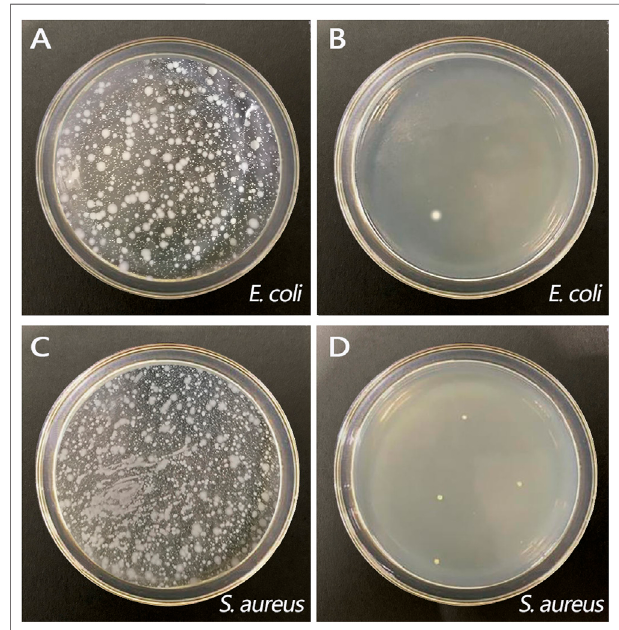
FIGURE 4 | Digital images of antibacterial activity of NW and CW. (A) Digital image of NW antibacterial activity against Escherichia coli . (B) Digital image of NW antibacterial activity against Staphylococcus aureus . (C) Digital image of CW antibacterial activity against Escherichia coli . (D) Digital image of CW antibacterial activity against Staphylococcus aureus